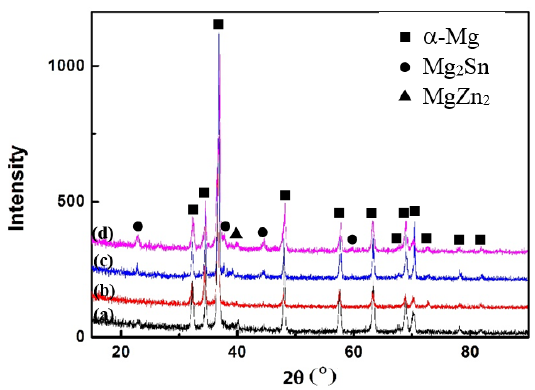
Figure 3. XRD patterns of the TZA442 alloy in different states: ( a ) the as-cast state; ( b ) the solid solution-treated state; ( c ) the 10-hour-aged state; ( d ) the 50-hour-aged state.